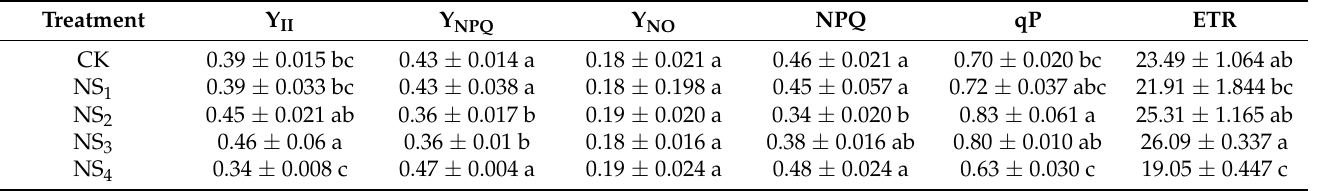
Table 3. Effects of foliage spraying of NaHSO 3 on chlorophyll a fluorescence parameters in O. violaceus leaves.